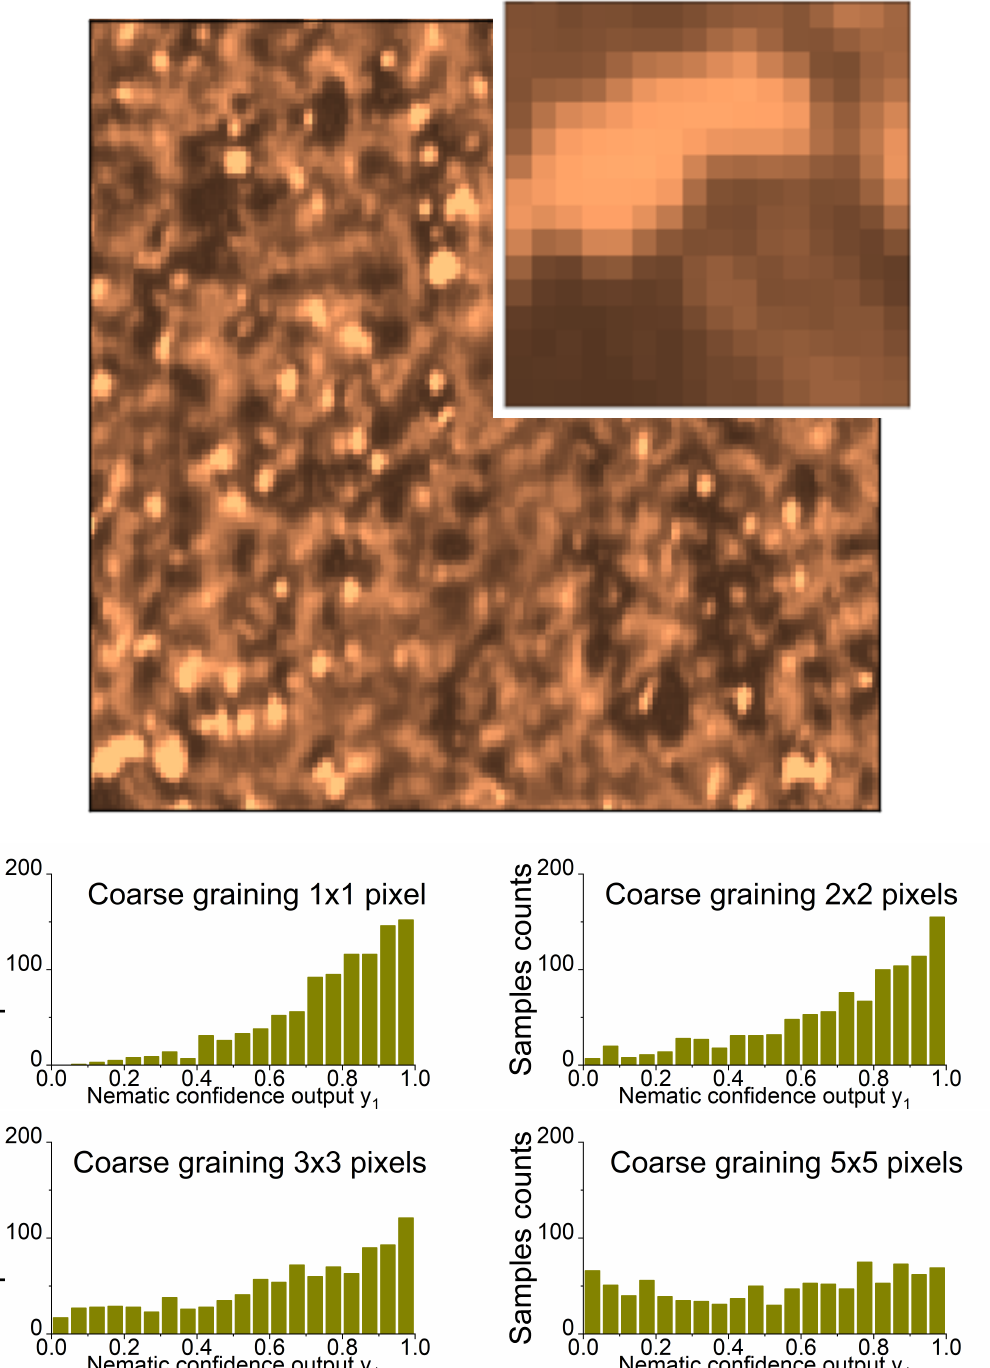
Figure 4: (Top) Data taken from Ref. [ 19 ] Supplementary materials fig. S3f (same as Fig. 2b of Ref. [ 19 ] ) and converted to a monochrome color scale. (Top inset) A typical 16x16 image cut of the data consistent with the input format of the ANN. We take various images as such across the field of view. (Bottom) the distribution of the neuron output y as ANN confidence of the nematic phase among 1000 sample 1 images randomly selected across the field of view. The neural outputs show clear confidence for a nematic phase, which gradually wane as the coarse-graining scale increases.